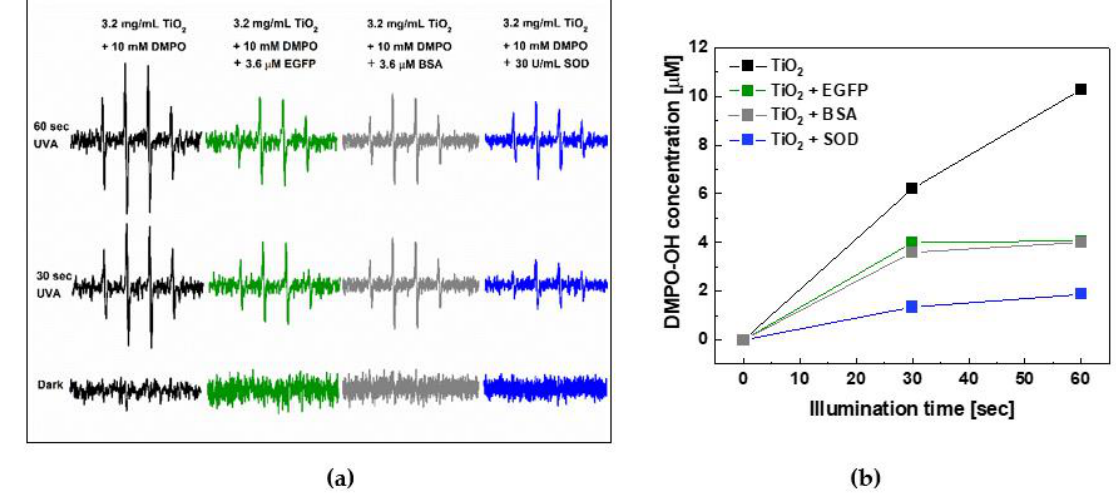
Figure 5. The ROS quenching ability of EGFP towards photocatalytically generated ROS in the presence of 10 mM DMPO and nano-TiO 2 , AMT-100 (3.2 mg/mL) in comparison with SOD and BSA, under UVA illumination (λ = 365 nm, 20 mW/cm 2 ). ( a ) Typical ESR spectra of the DMPO-OH spin adduct acquired in the absence of proteins (black), the presence of 3.6 μM EGFP (green) or 3.6 μM BSA (grey), and the presence of 30 U/mL of a superoxide radical scavenging protein, SOD, obtained in the dark and after 30 and 60 s of UVA illumination. ( b ) The time-evolution plots acquired in the absence of protein (black), the presence of EGFP (red), BSA (grey), and SOD (blue).